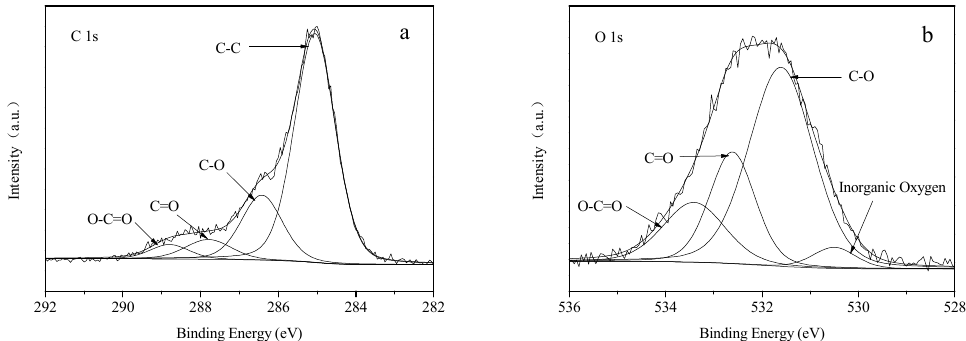
Figure 2. Fitting results of C1s and O1s XPS spectra of dry sewage sludge. ( a ) C1s; ( b ) O1s.